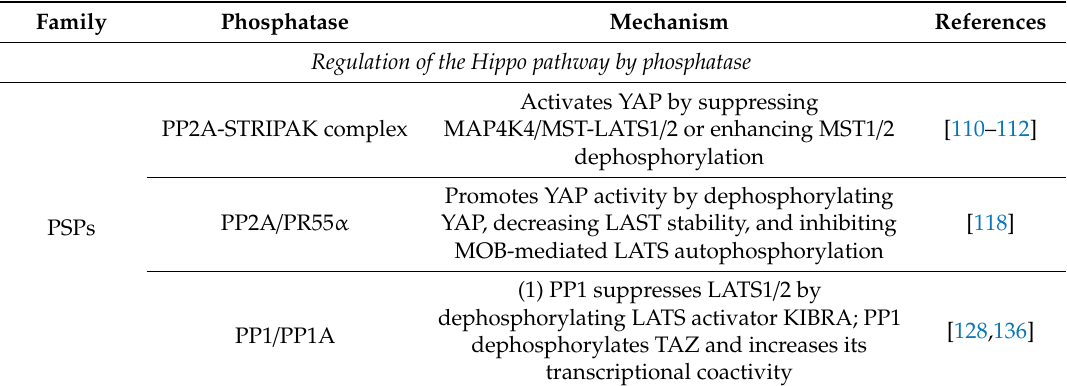
Table 1. Interaction of phosphatase and the Hippo